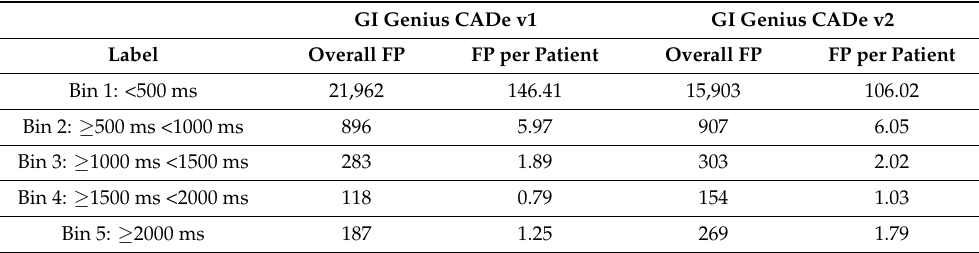
Table 2. False-positive clusters for GI Genius CADe. The performances of different CADe modules regarding FPs can be more easily and objectively compared when using this approach. It could be acceptable to only consider the clusters that are longer than a given time threshold as FPs, as suggested by Holzwanger and co-authors [42]. In this case, the performances of GI Genius CADe are in agreement with the subjective results of Hassan et al. [23], corresponding to 1 to 2 FPs per colonoscopy, both easily identified by the endoscopist as such, without any effect on the withdrawal time. GI Genius CADe